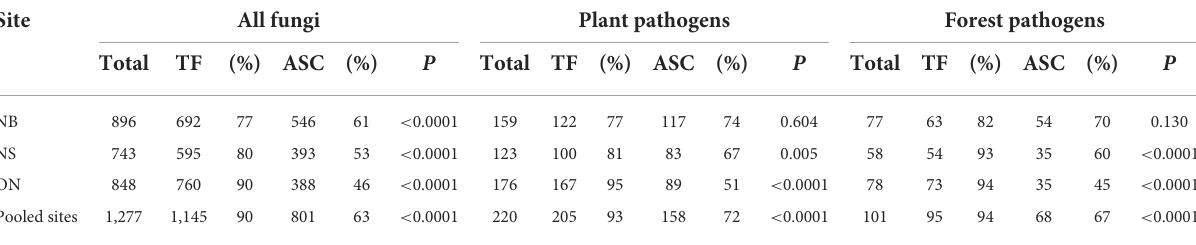
TABLE 1 Number (%) of OTUs of all fungi, plant pathogens, and forest pathogens detected at each site by trap fluids (TF) vs. aerial spore collectors (ASC). Site All